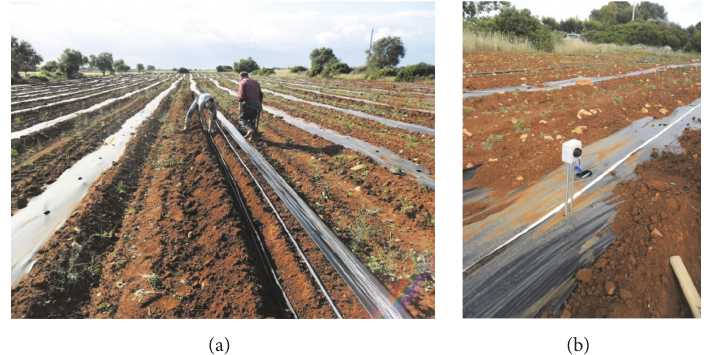
Figure 4: Experiment #2: (a) picture of the arrangement of the elongate SEs. (b) Picture of one of the vertical probes.